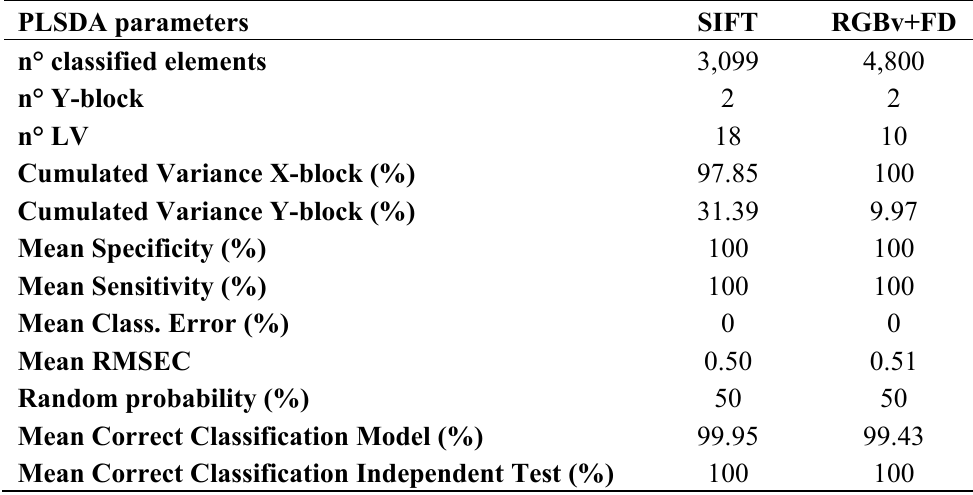
Table 1. Results of PLSDA models on SIFT and RGBv+FD (see the text for acronyms definition). Some of the different reported parameters are: the number of units to be discriminated by the PLSDA (n° Y-Block); the number of latent vectors for each model (n° Latent Vectors-LV); and finally, the probability of random assignment of an individual into a category. RMSEC is the Root Mean Square Error of Calibration.